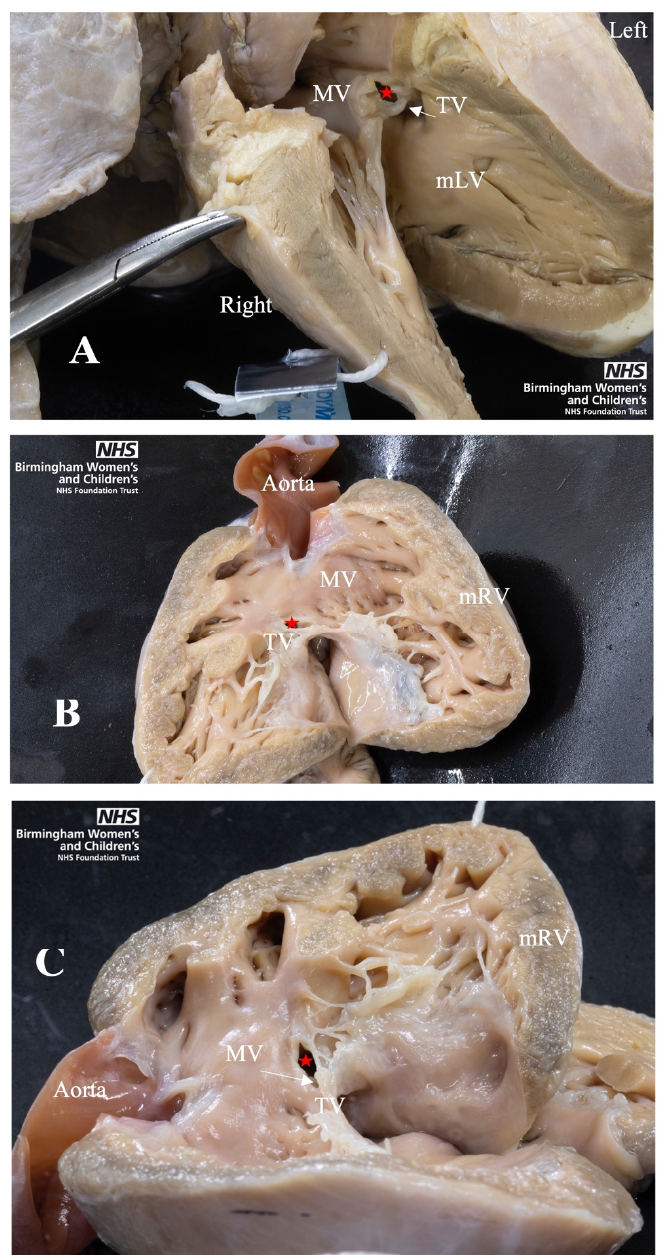
Figure 5. Four Associated Anomalies of ccTGA. ( A ) Photo from mLV showing Peri-membranous VSD. ( B ) Photo from mRV showing Peri-membranous VSD. ( C ) Photo from mRV using mirror so the ventricle appears right sided. Geographies of VSD assessed as central. Star: VSD; MV, Mitral Valve; TV, Tricuspid Valve; mLV, morphological left ventricle; mRV, morphological right ventri- cle.